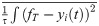
Hierarchical organization of multi-finger force variability in a redundant hand system.The overall mean squared error (1τ∫(fT-yit)2-) is composed of or the linear sum of the intra-trial moment-to-moment (online) variable error (VarX-), the trial-to-trial time-averaged (offline) variable error (VarE) and the systematic error (fT-m2) at the virtual finger (VF) level where the task is performed with the sum of two finger forces (VF force). The online and offline variable errors at the VF level are composed of or the linear sum of individual finger (IF) force variances (∑j = 1nVarxj- and ∑j = 1nVarεj) and between-finger force covariances (∑j≠kCovxj,xk- and ∑j≠kCovεj,εk) at the IF level.